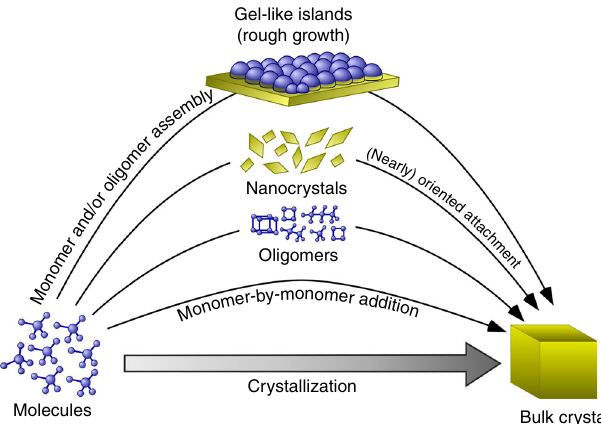
Fig. 5 Distinct pathways of LTA crystallization. Illustrative renderings of crystal growth mechanisms for classical and nonclassical pathways. The former involves monomer-by-monomer addition that leads to growth by spirals (Fig. 1f), 2D layers (Fig. 4a), or kinetic roughening (Fig. 4d – f). In this study, we observe a unique nonclassical pathway at low temperature ( T < 40 °C) wherein roughness derives from the formation of 3D gel-like islands (Fig. 2a – f). At higher temperatures, nucleation within the growth solution can lead to (nearly) oriented attachment of crystals to LTA